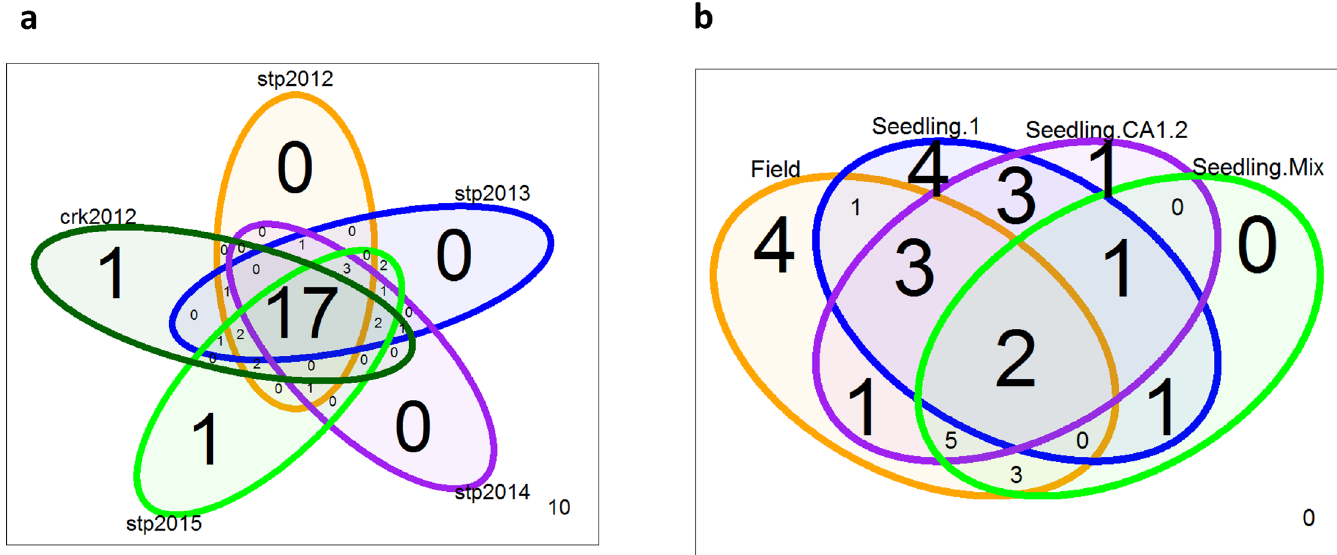
Fig 6. Venn diagrams (a) Overlap between QTLs under different field environments. (b) Overlap between field and seedling